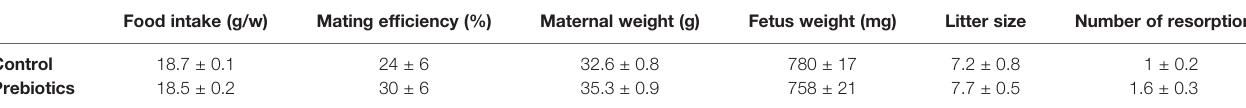
TABLE 1 | Effects of GOS/inulin supplementation during pregnancy on gestational outcomes. Food intake